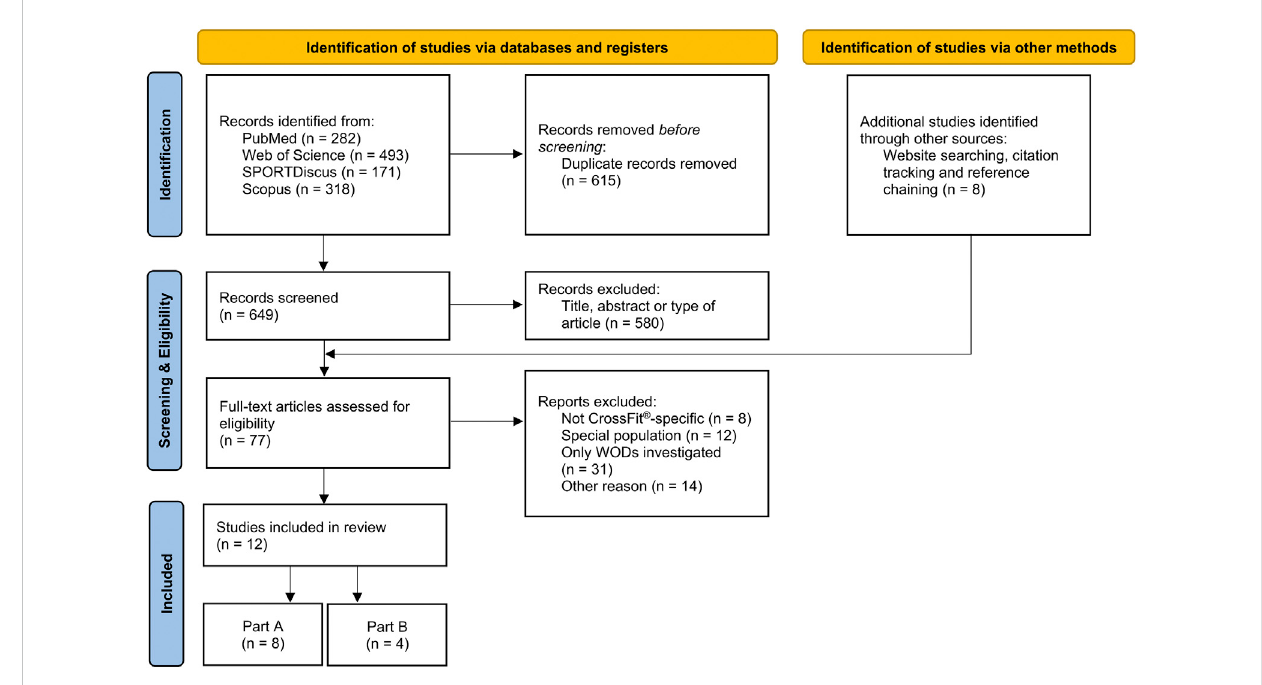
FIGURE 1 PRISMA fl ow diagram of the search strategy. Abbreviation: Workout of the Day